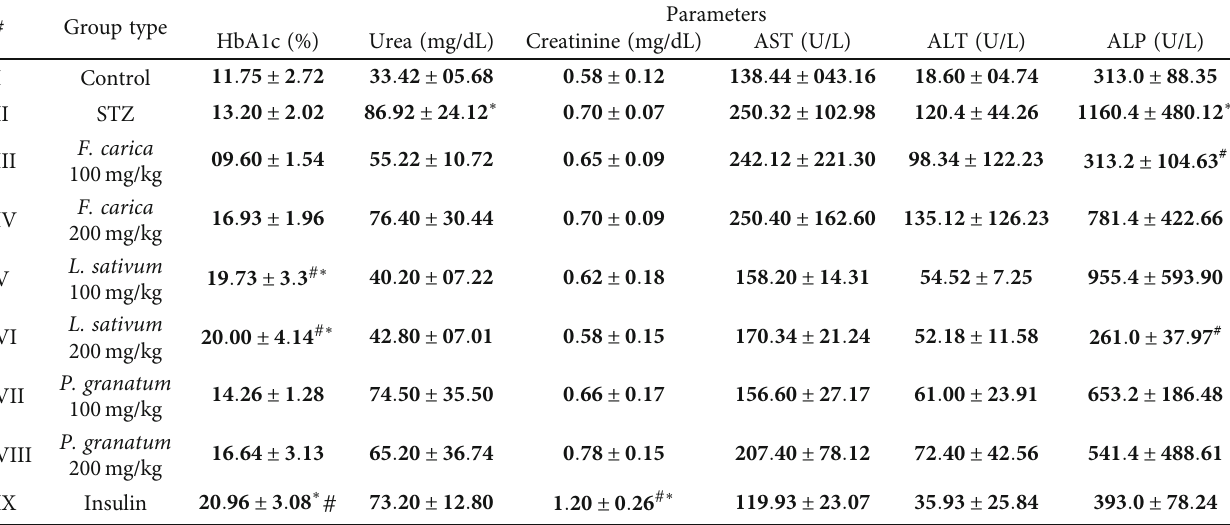
Values are given as mean ± SD signi fi cantly di ff erent at p < 0 : 05 for groups of nine animals each. ∗ Statistically signi fi cant compared to the corresponding value in group I. # Statistically signi fi cant compared to the corresponding value in group II. Table 6: E ff ect of di ff erent Lepidium sativum , Ficus carica , and Punica granatum methanolic extracts on the liver NO, MDA, CAT, and GSH in STZ-induced diabetic rats after 5 weeks.